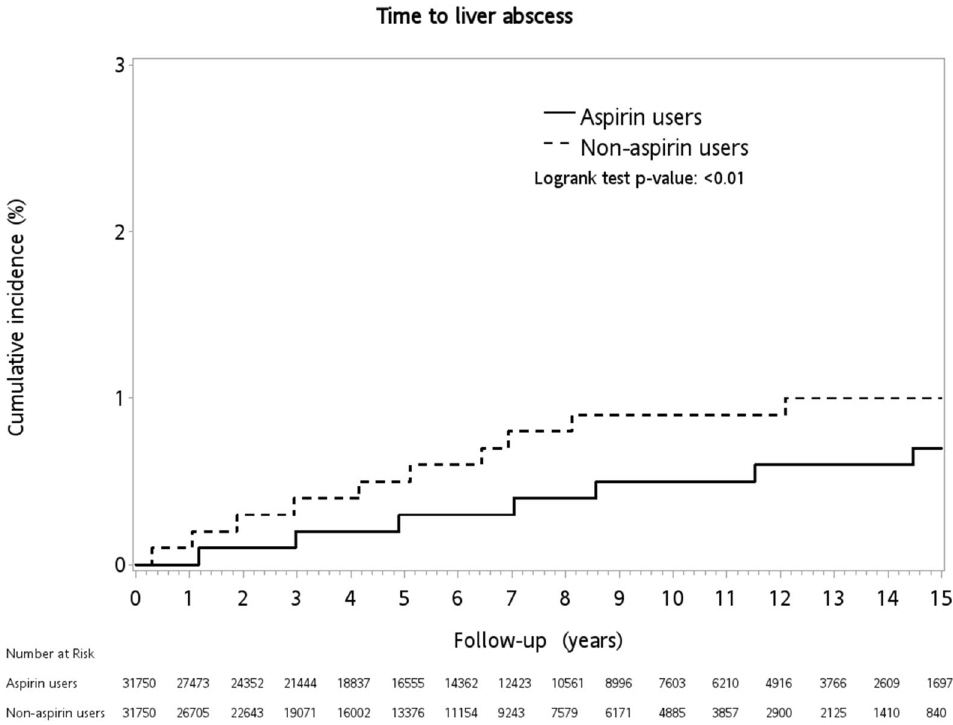
Figure 2. Kaplan–Meier curve of the incidence of Klebsiella pneumoniae liver abscess in diabetic patients with or without aspirin